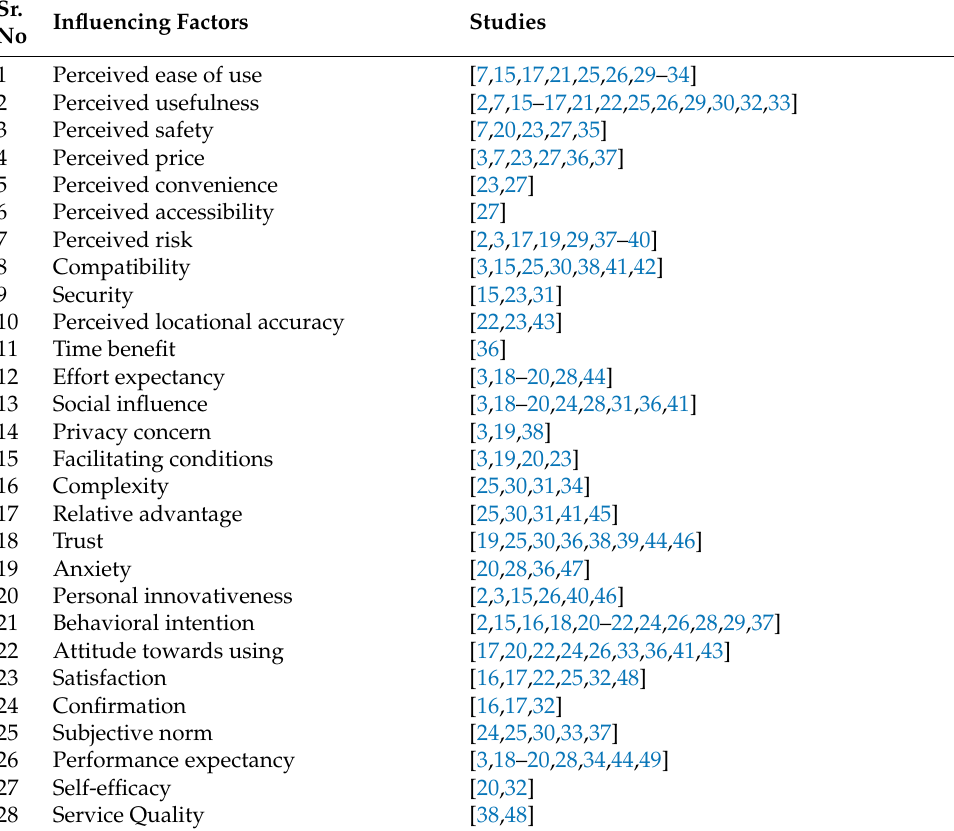
Table 3. Influencing